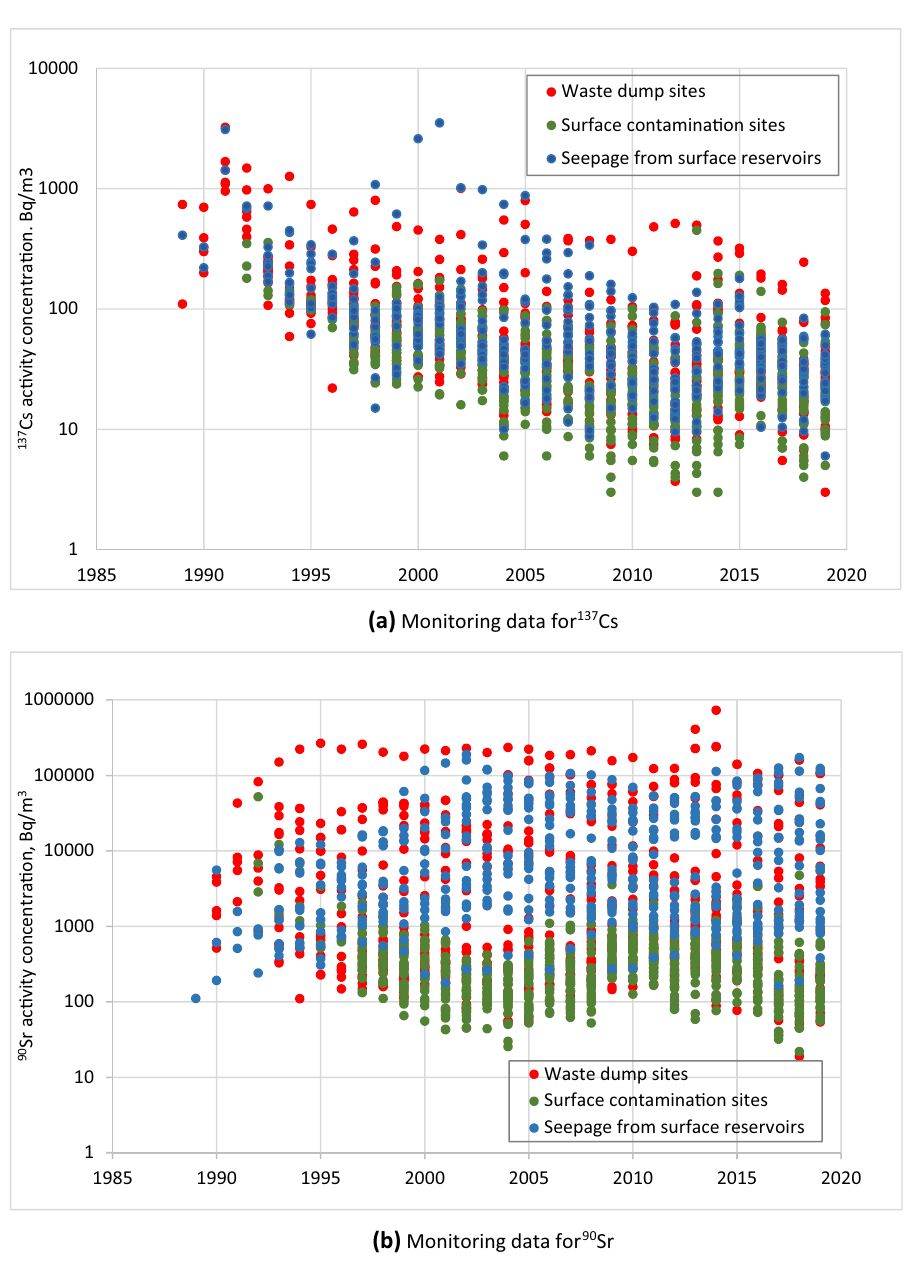
Figure 5. Time series of radionuclide activity concentrations in the unconfined aquifer for sites with different types of sources of groundwater contamination for the integral set of monitoring wells (monitoring data set is provided in Annex